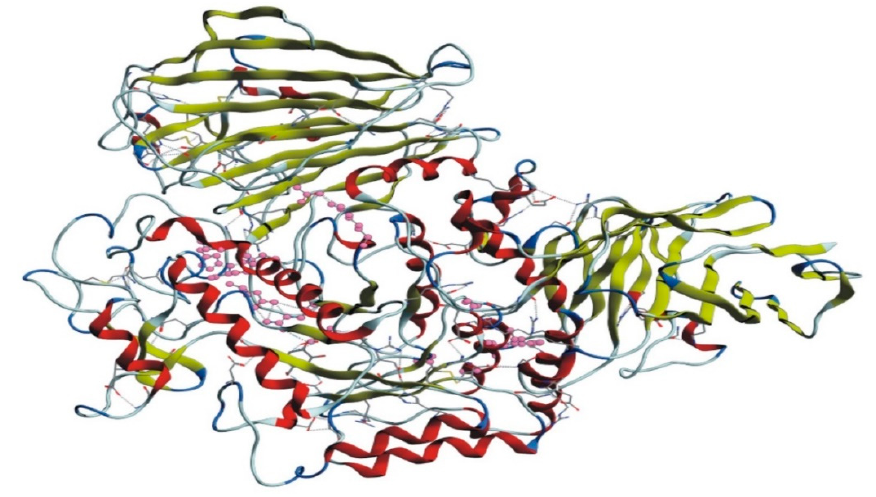
Figure 3. 3D modeled structure of α -glucosidase.